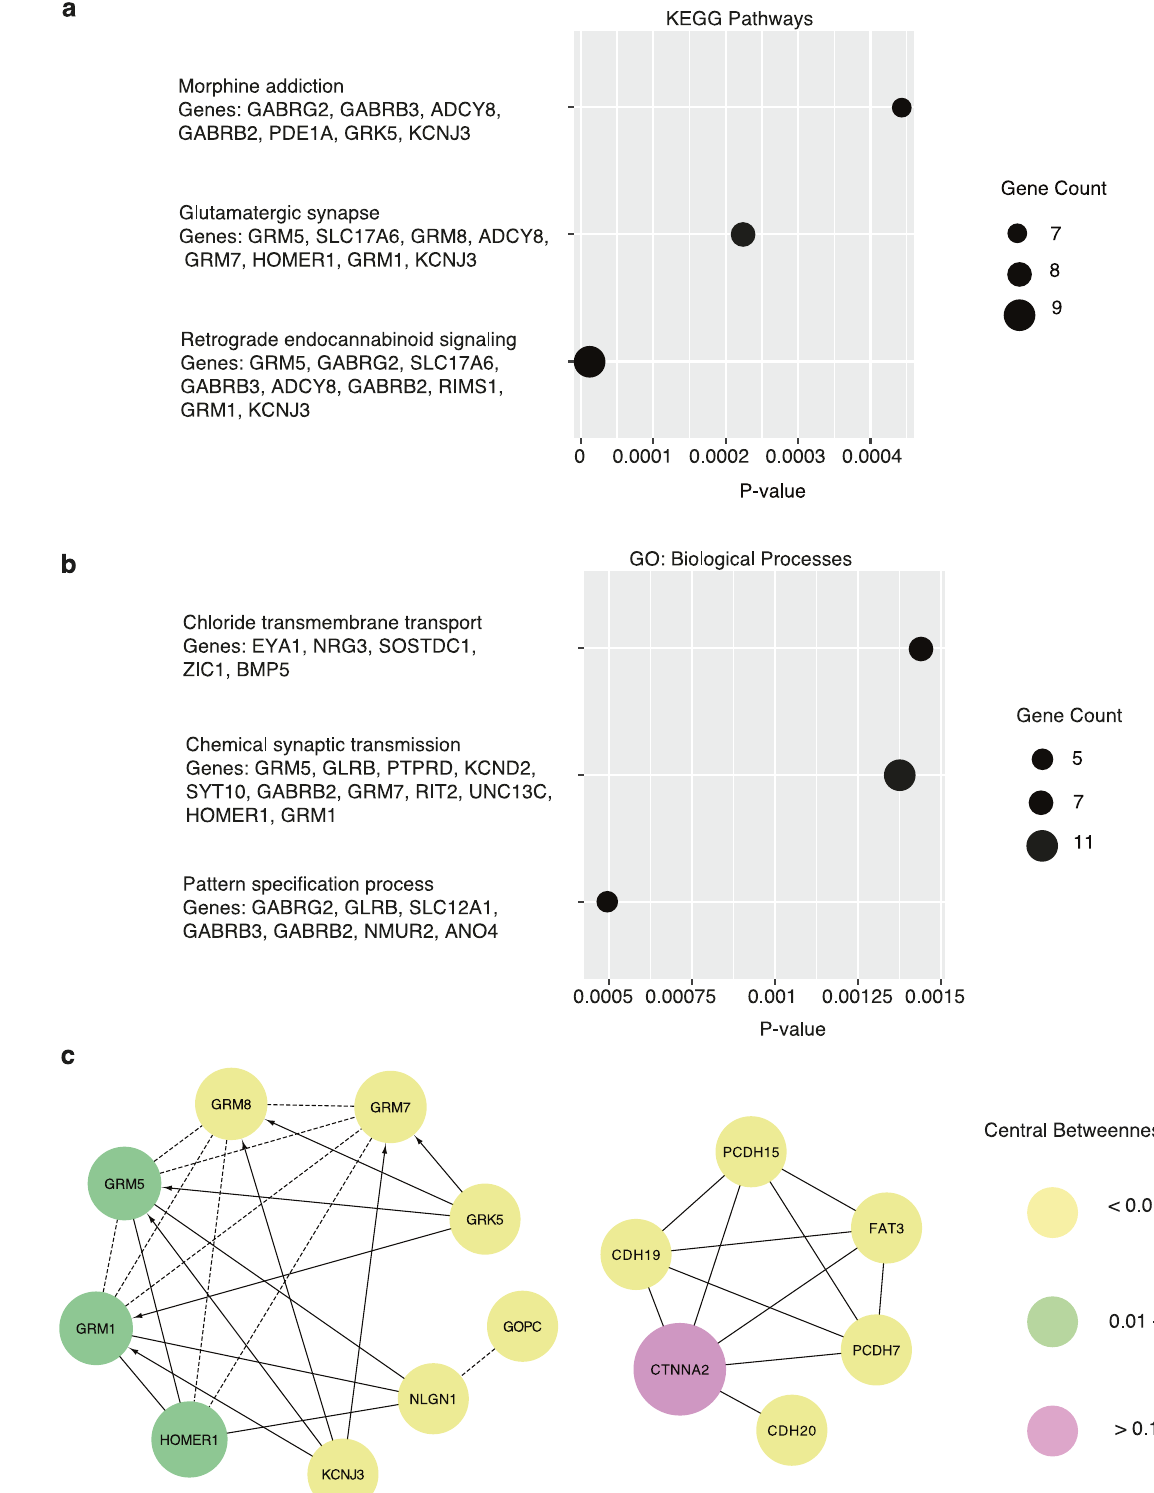
Fig. 4 Functional relevance of the differentially modi fi ed genes between DLBCL and FL. Enriched pathways and biological processes are observed among the 294 differentially modi fi ed genes between DLBCL and FL: a KEGG pathways; and b GO biological processes. c Reactome FI network analysis detects links among a subset of differentially modi fi ed genes. The node size is proportional to the central betweenness measurement that denotes the importance of a gene in the FI network. KEGG Kyoto Encyclopedia of Genes and Genomes, GO gene ontology, FI functional interaction, DLBCL diffuse large B-cell lymphoma, FL follicular